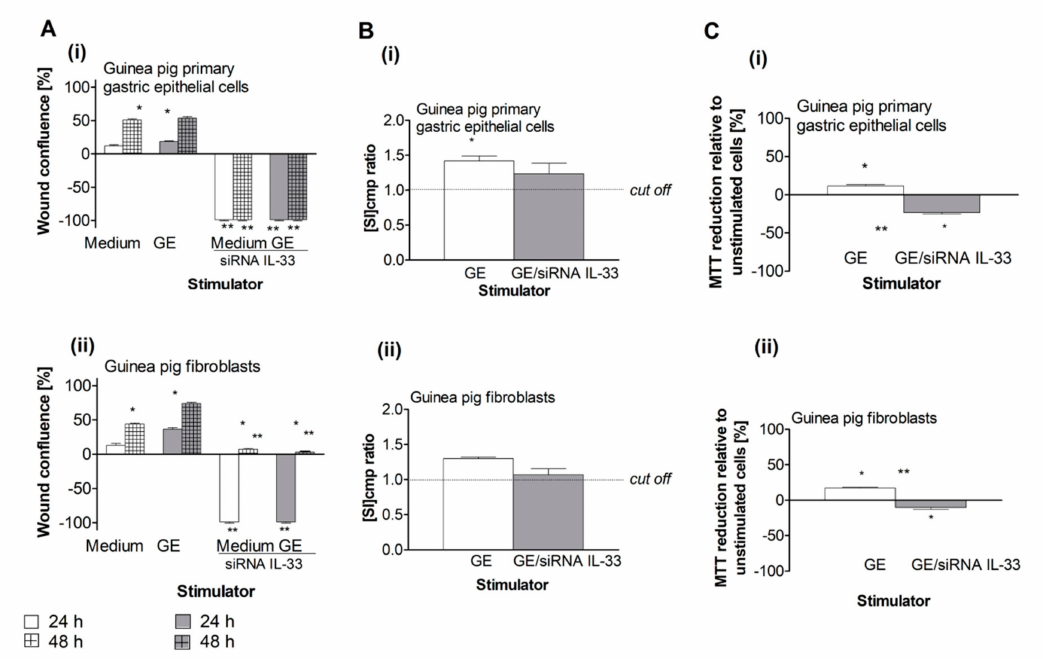
Figure 3. Pro-regenerative activity of IL-33 in the cell cultures exposed to H. pylori components. ( A ) Migration e ff ectiveness of the guinea pig primary gastric epithelial cells ( i ) or fibroblasts ( ii ), not transfected or transfected with siRNA IL-33, cultured in medium only or in the milieu of H. pylori glycine acid extract (GE), expressed as the percentage of wound confluence in the scratch assay. ( B ) Proliferation of the guinea pig primary gastric epithelial cells ( i ) or fibroblasts ( ii ) untransfected or transfected with siRNA IL-33 in medium only or in the milieu of H. pylori GE, estimated in a radioactive assay. Proliferation is shown as stimulation index (SI), which was calculated, expressed as cpm ratio of unstimulated vs GE stimulated cells. ( C ) Metabolic activity of the guinea pig primary gastric epithelial cells ( i ) or fibroblasts ( ii ), not transfected or transfected with siRNA IL-33, expressed as the 3-(4,5-dimethylthiazol-2-yl)-2,5-diphenyltetrazolium bromide (MTT) reduction by stimulated cells relative to unstimulated cells. Results are showed as a median with a range of five experiments performed in triplicates for each experimental variant. Statistical analysis was performed using the nonparametric U Mann-Whitney test with significance for *, ** p < 0.05, * unstimulated (only medium) vs. GE stimulated, untransfected or tranfected cells, ** untransfected vs. transfected cells in medium only or in medium with